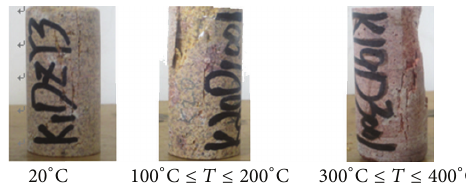
Figure 8: Ordinary damage states under uniaxial pressure.